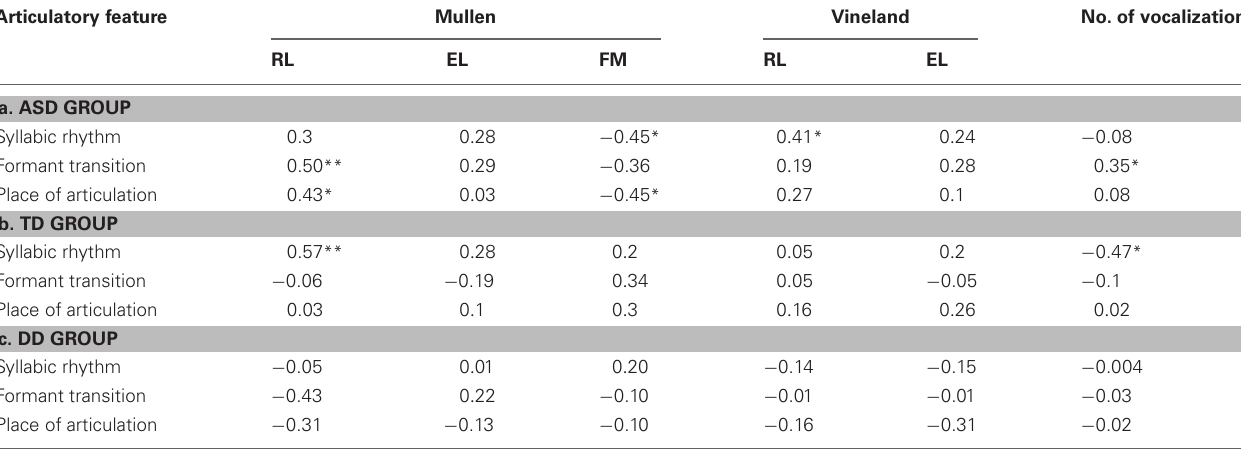
Table 2 | Correlations among language variables for children in the groups ASD, TD, and DD. Articulatory